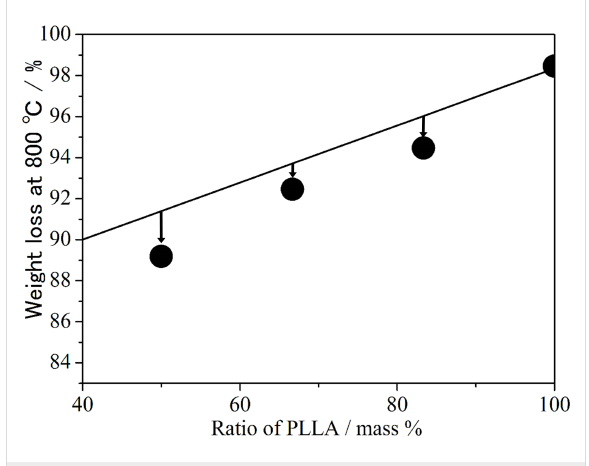
Figure 2: Observed weight loss and stoichiometric line.